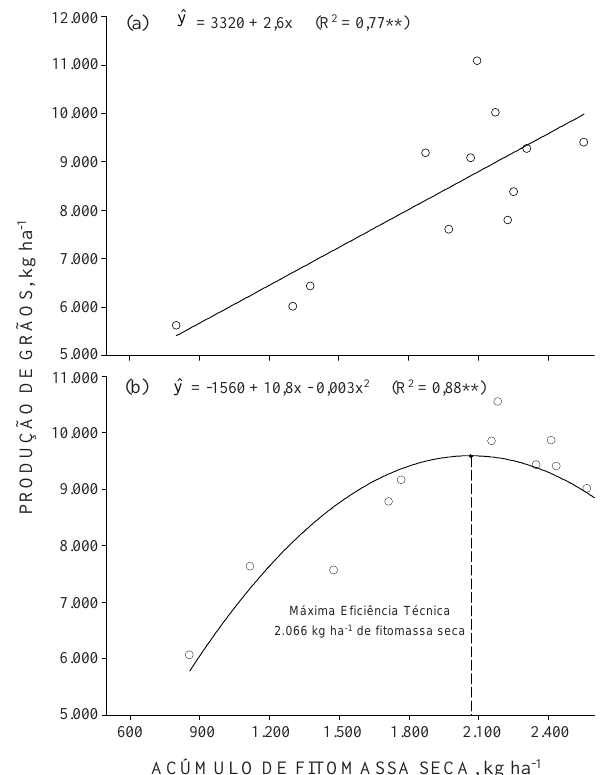
Figura 6. Produtividade de grãos de milho para as parcelas que receberam 0 kg ha -1 (a) e 60 kg ha -1 (b) de N como adubação de verão (N-TV) de acordo com o acúmulo de fitomassa seca resultante do rebrote da cultura de inverno, Guarapuava (PR)